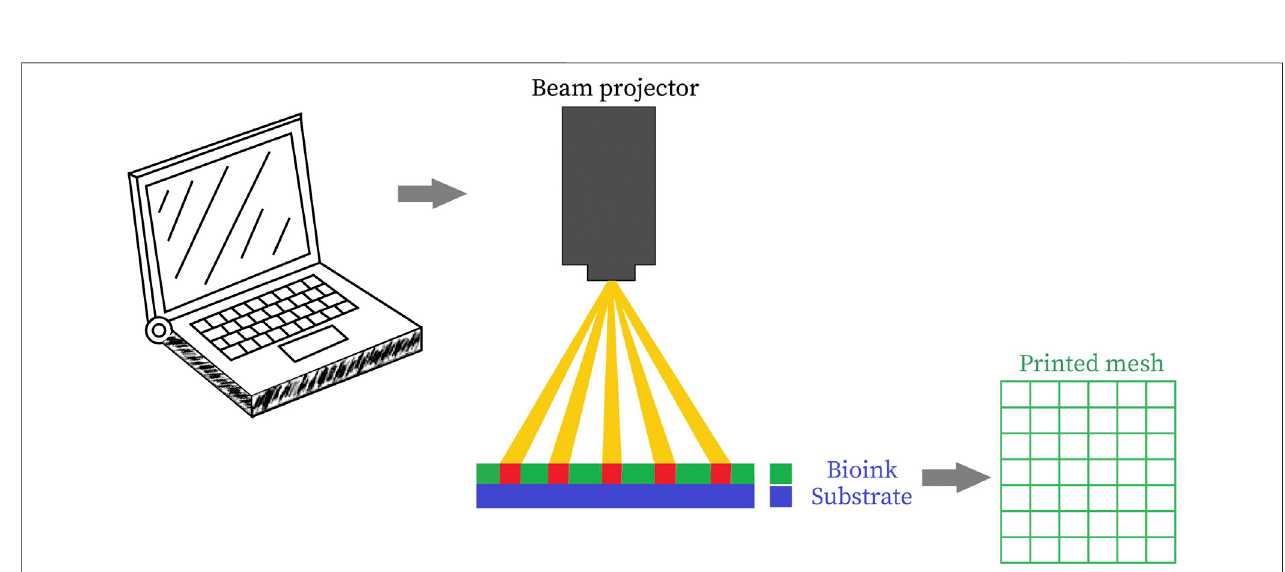
FIGURE 5 | Schematic representation of stereolithographic 3D bioprinting (Derakhshanfar et al., 2018) (used from an open access journal).